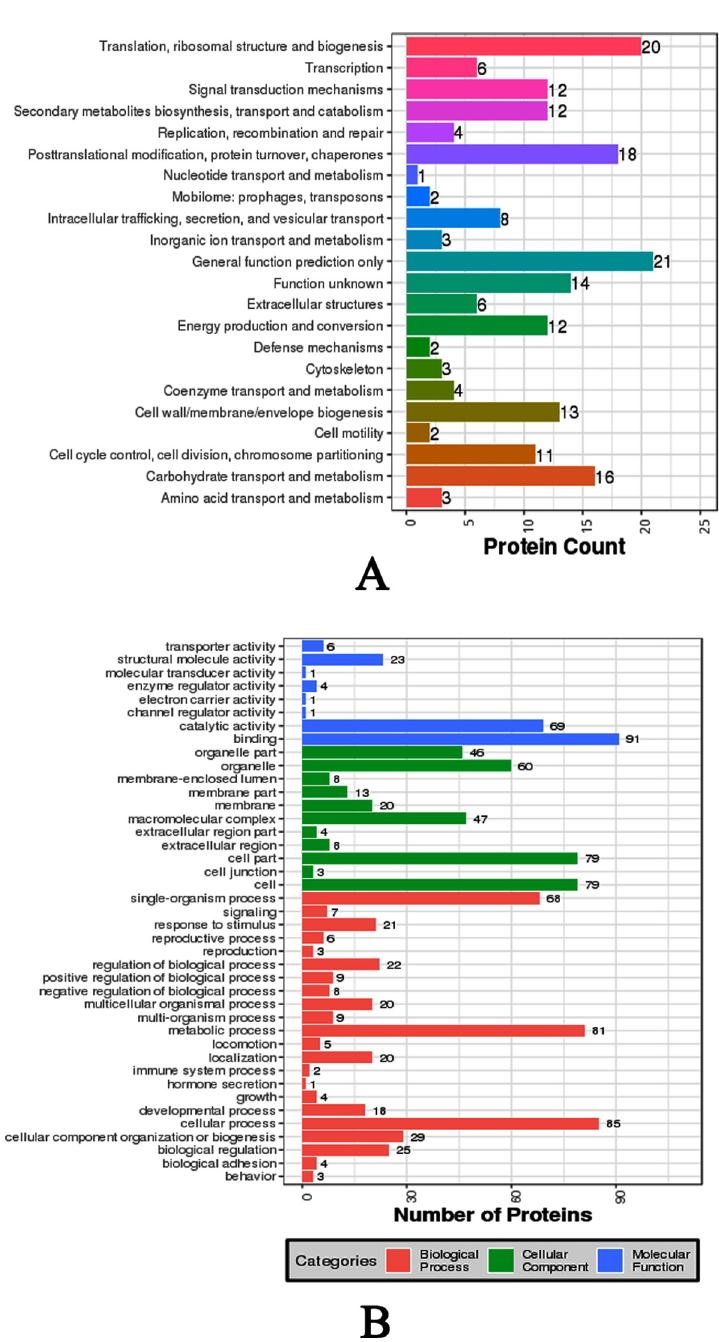
Fig 11. Functionally annotation of the nacre SMPs identified from P . viridis shell. A : COG annotation of the SMPs from the nacrelayer; B : GO annotation of the SMPs from the nacre